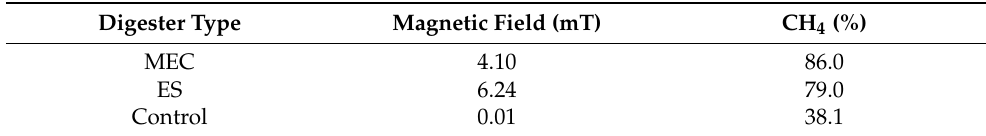
Table 2. Magnetic field and methane content in the